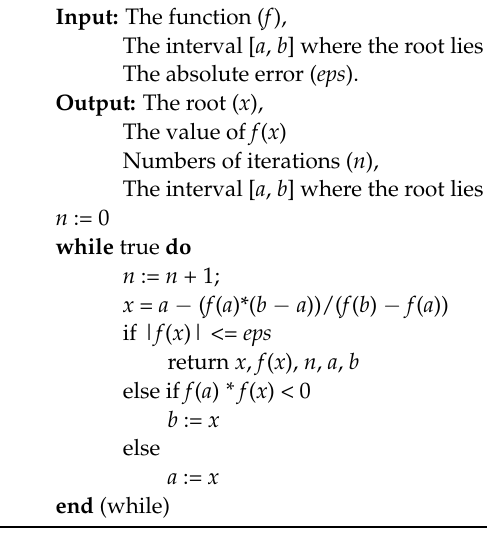
Algorithm 3. False Position( f , a , b , eps